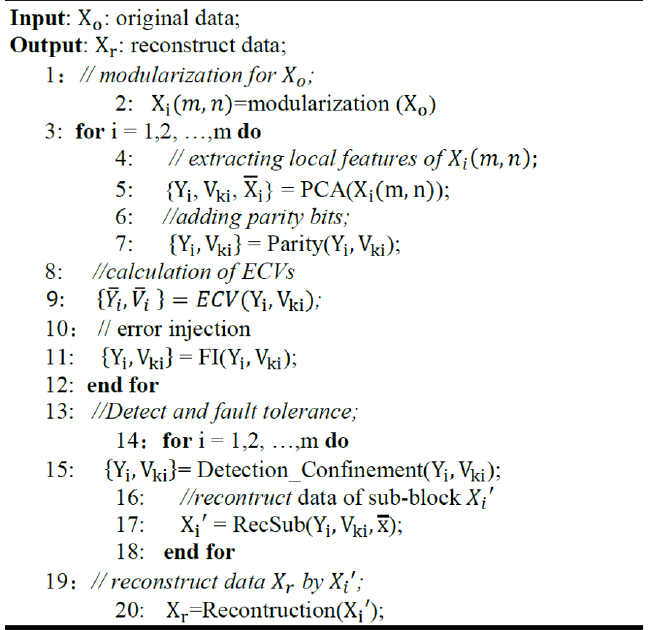
Figure 8. Pseudo code: error confinement for memory based on